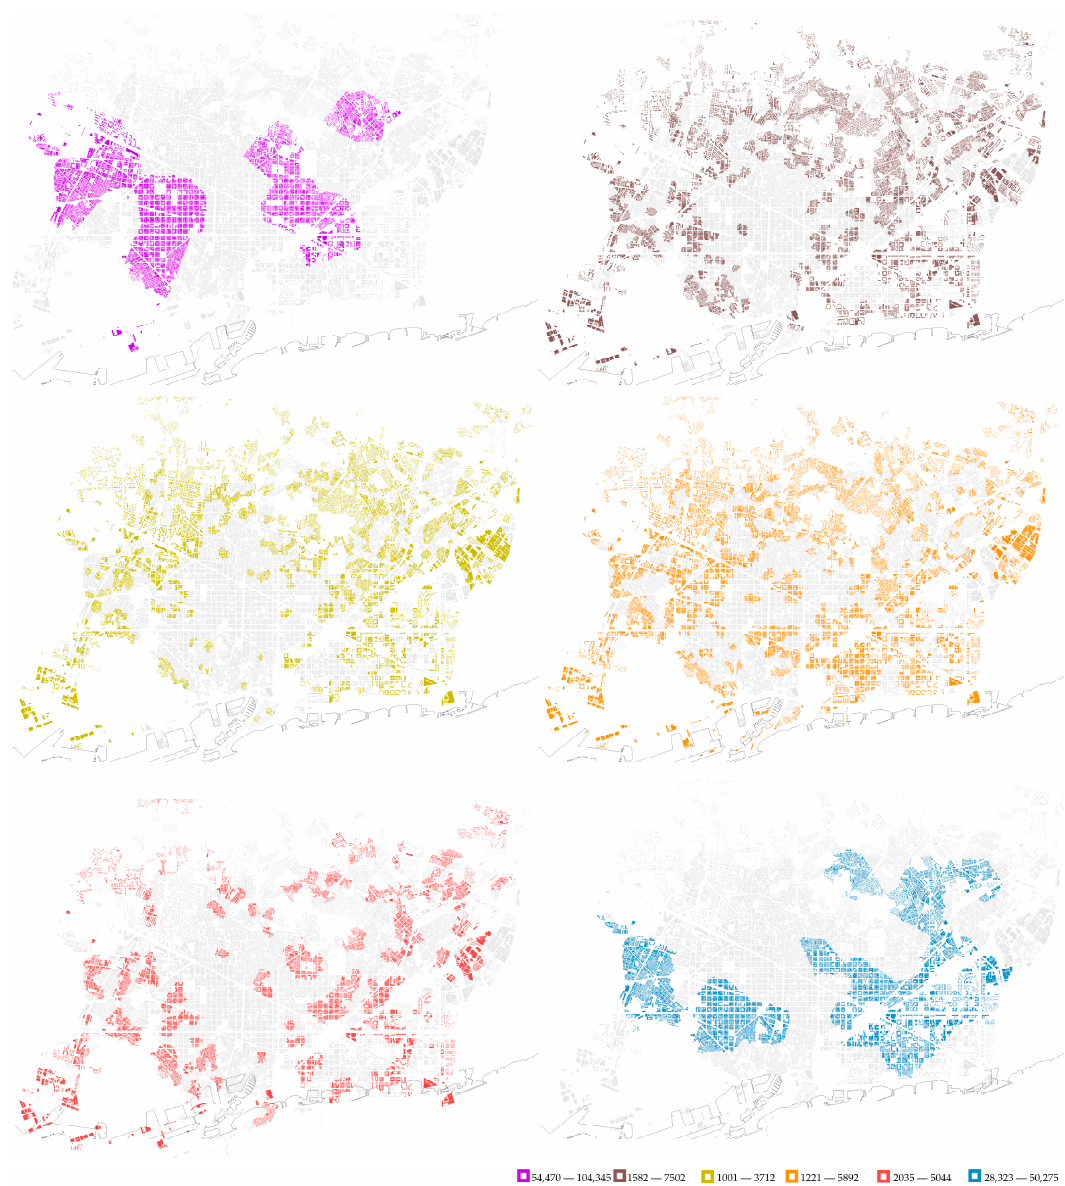
Figure 5. Places with the highest population allocation for each category of essential services (from left to right and top to bottom: market halls, bakeries, supermarkets, grocery stores, pharmacies and healthcare facilities). Representation of the upper quintile of Figure 4 in relation to the urban